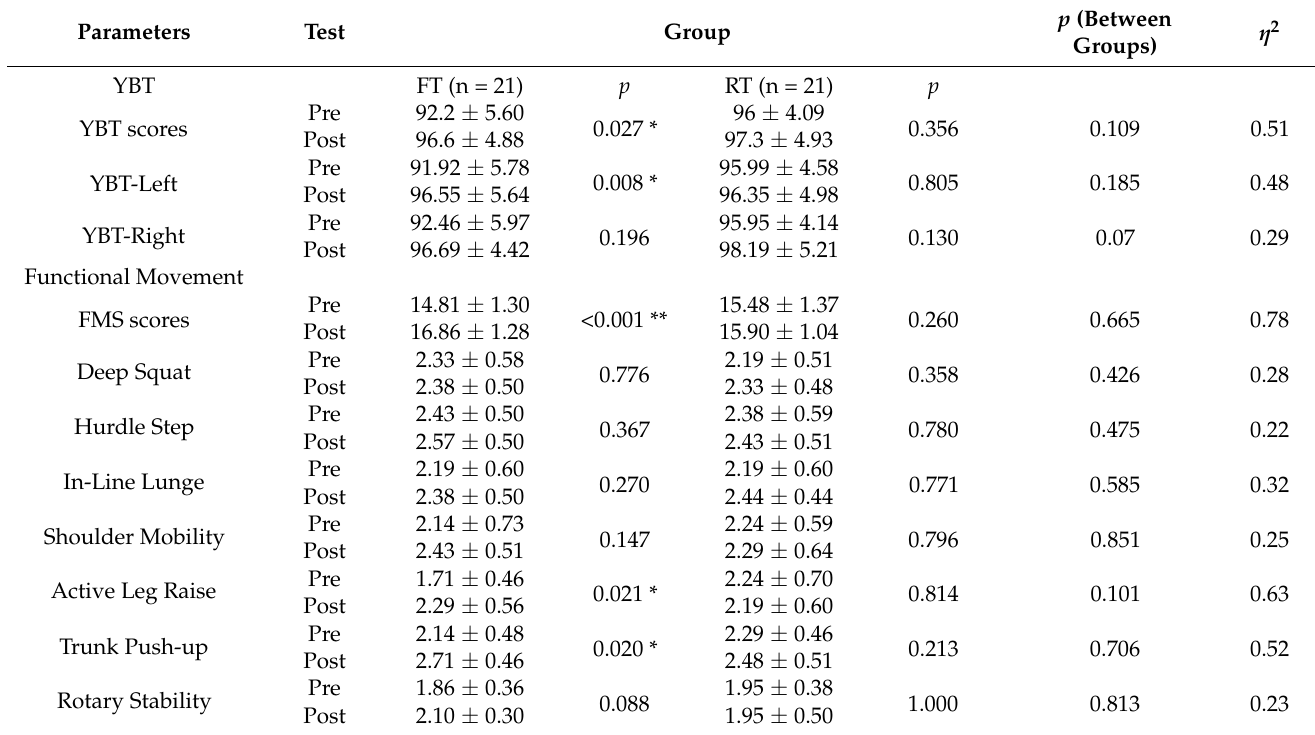
Table 3. YBT and FMS data from FT and RT groups.